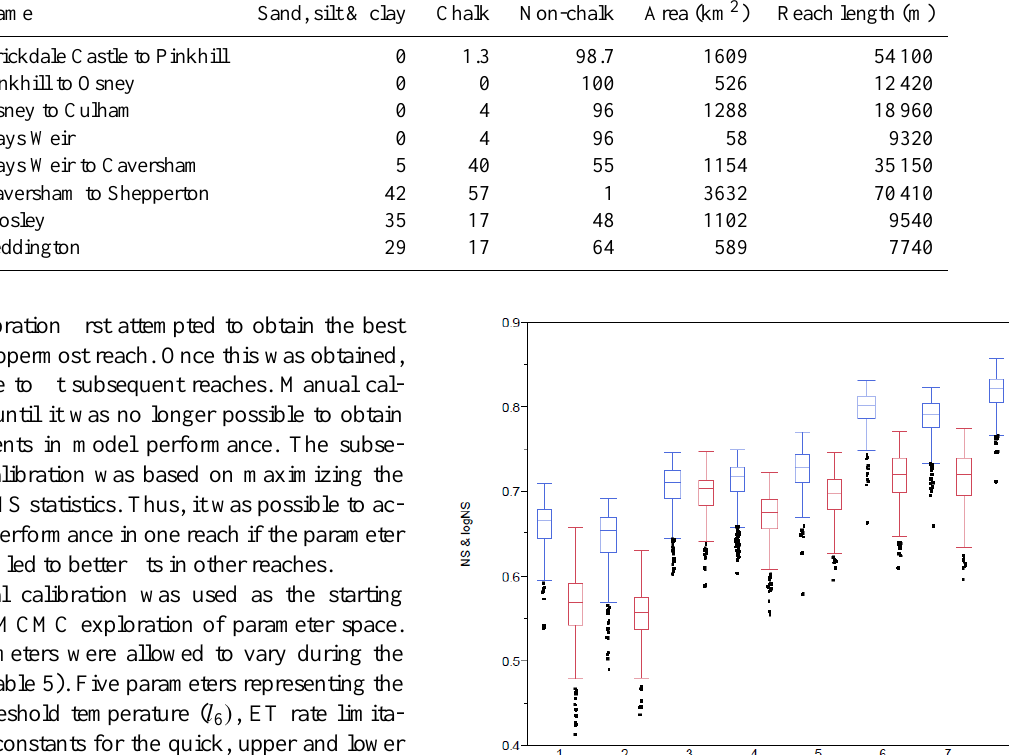
Table 4. Subcatchment and reach dimensions along with proportional cover of different landscape element types. No.